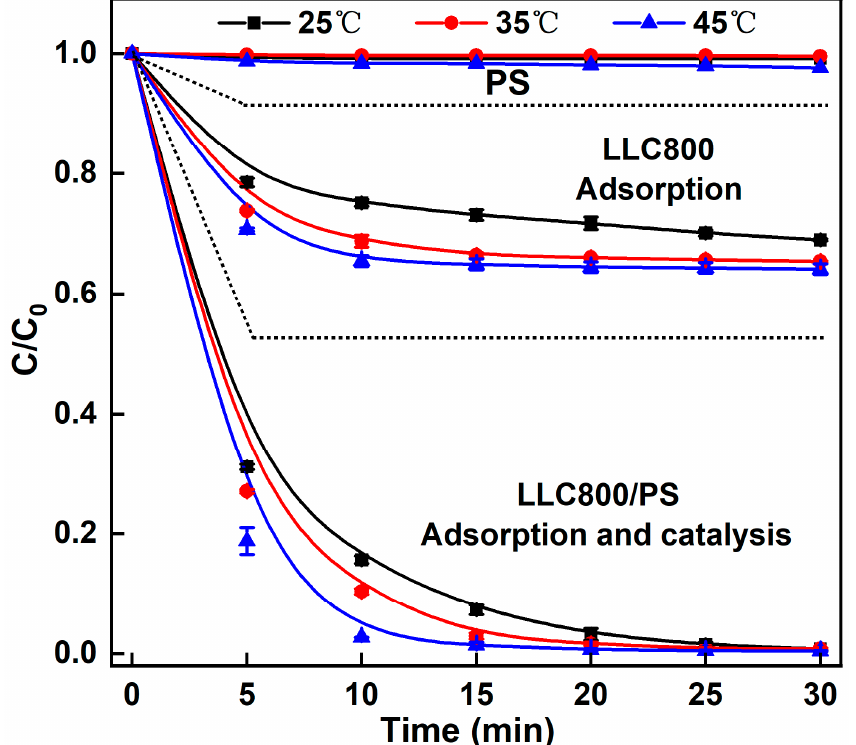
Figure 7. Effect of temperature on degradation efficiency.